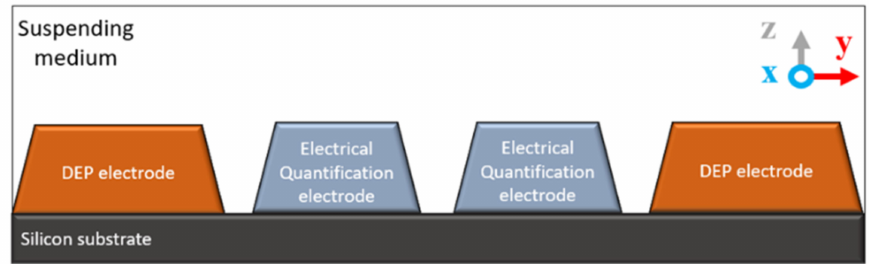
Figure 9. Integrated DEP & electrical quantification electrodes.